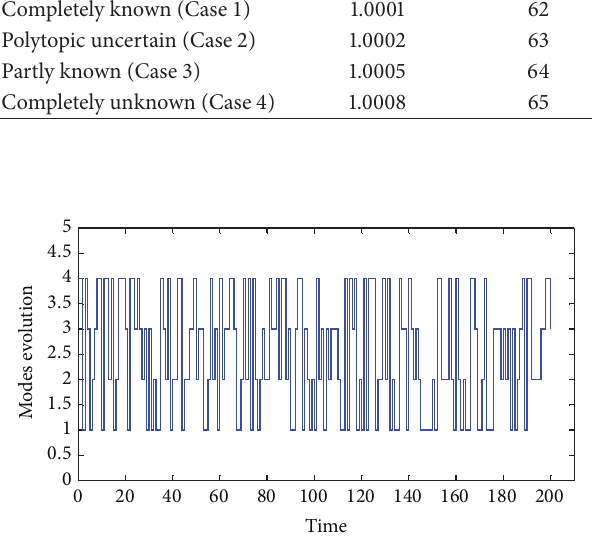
Figure 1: Modes evolution in Example